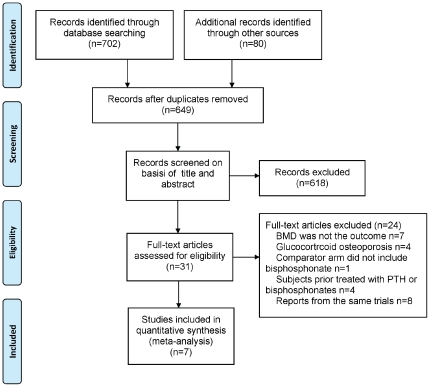
Flowchart of the meta-analysis.